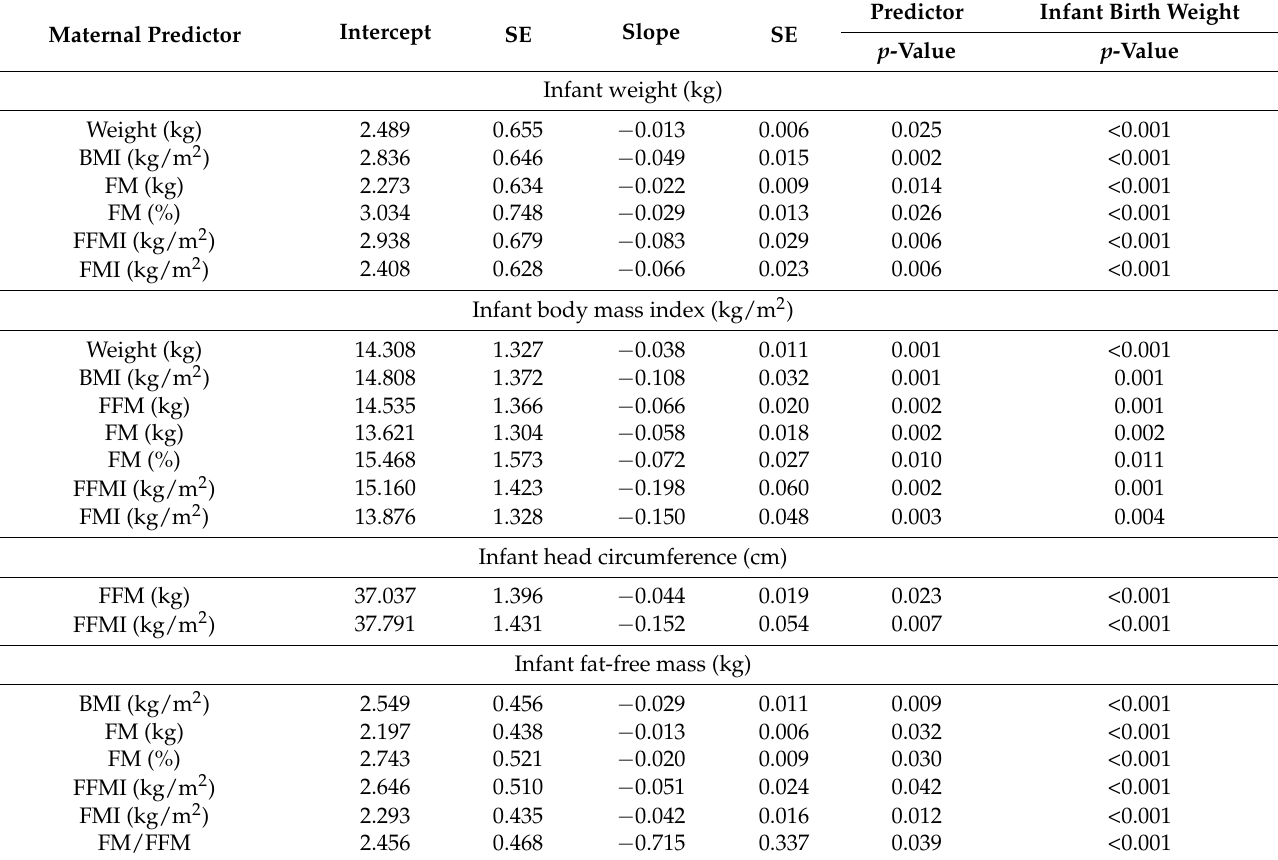
Table A3. Associations between infant and maternal body composition at 3 months